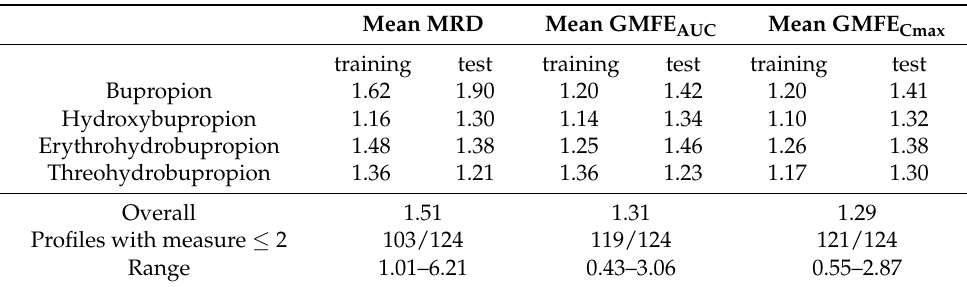
Table 3. Summary of quantitative measures of model performance for bupropion and its metabolites, separated by training and test